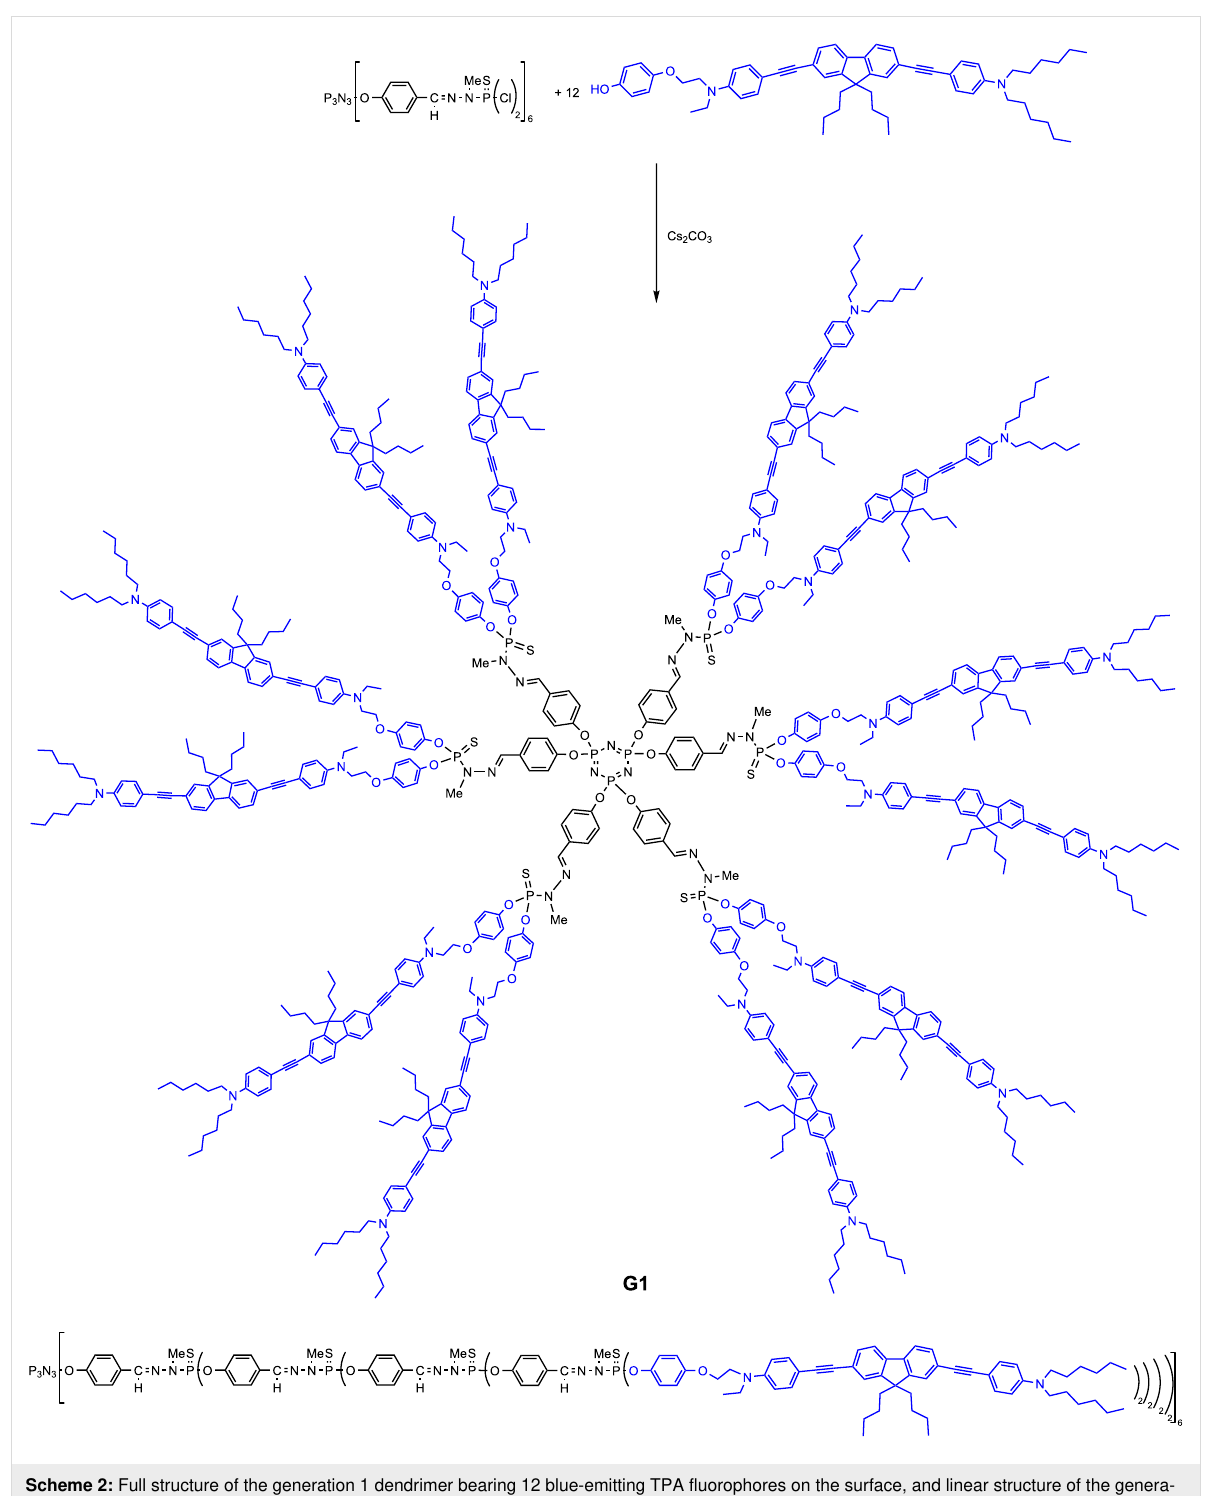
ing 24 fluorophores, compared to 1,400 GM for the correspond- ing monomer and 780 GM for the quantum dot QD518